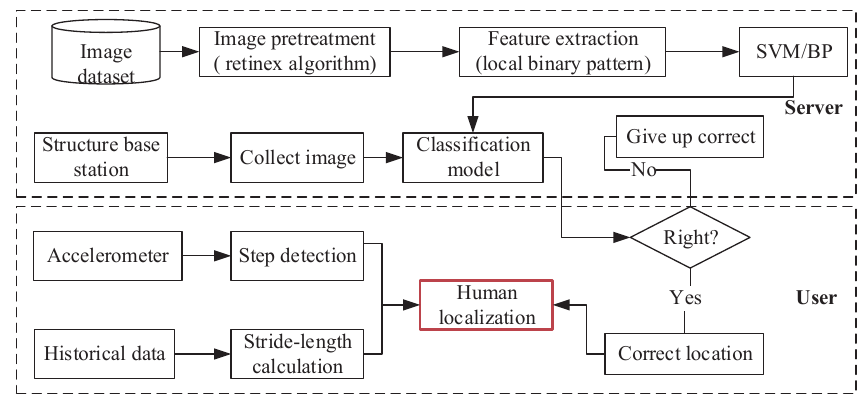
Figure 1. Algorithm architecture.